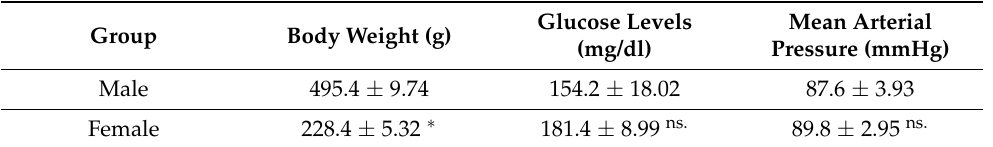
Table 1. Animal profile. Data are presented as means ± SEM, n = 5. * p < 0.05 and ns. p > 0.05 using two-tailed Student’s t